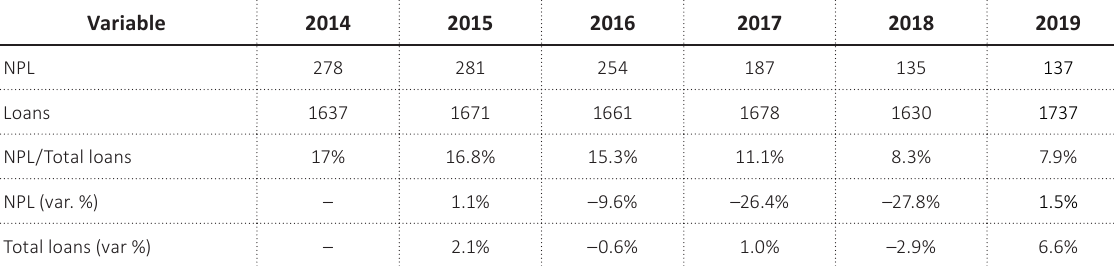
Source: EBA (2019).